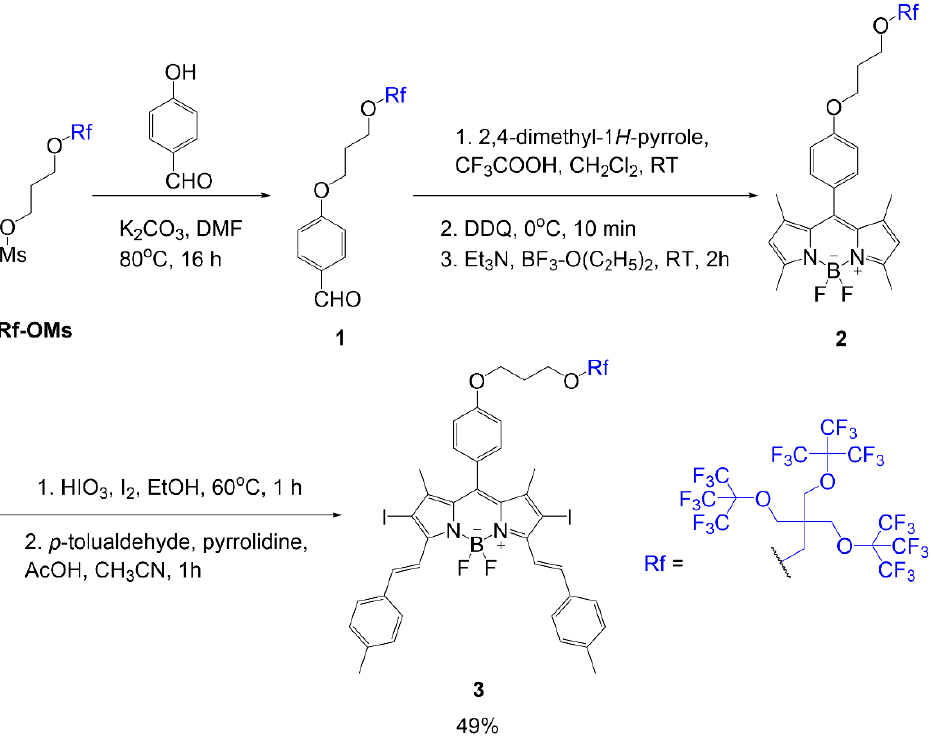
Scheme 1. BODIPY with multi-branched fluorinated chains on meso phenyl